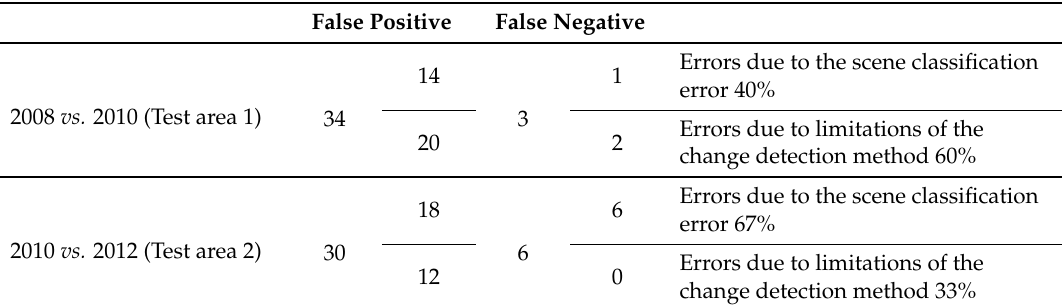
Table 5. Percentage of errors due to scene classification and errors due to the method of change detection used.